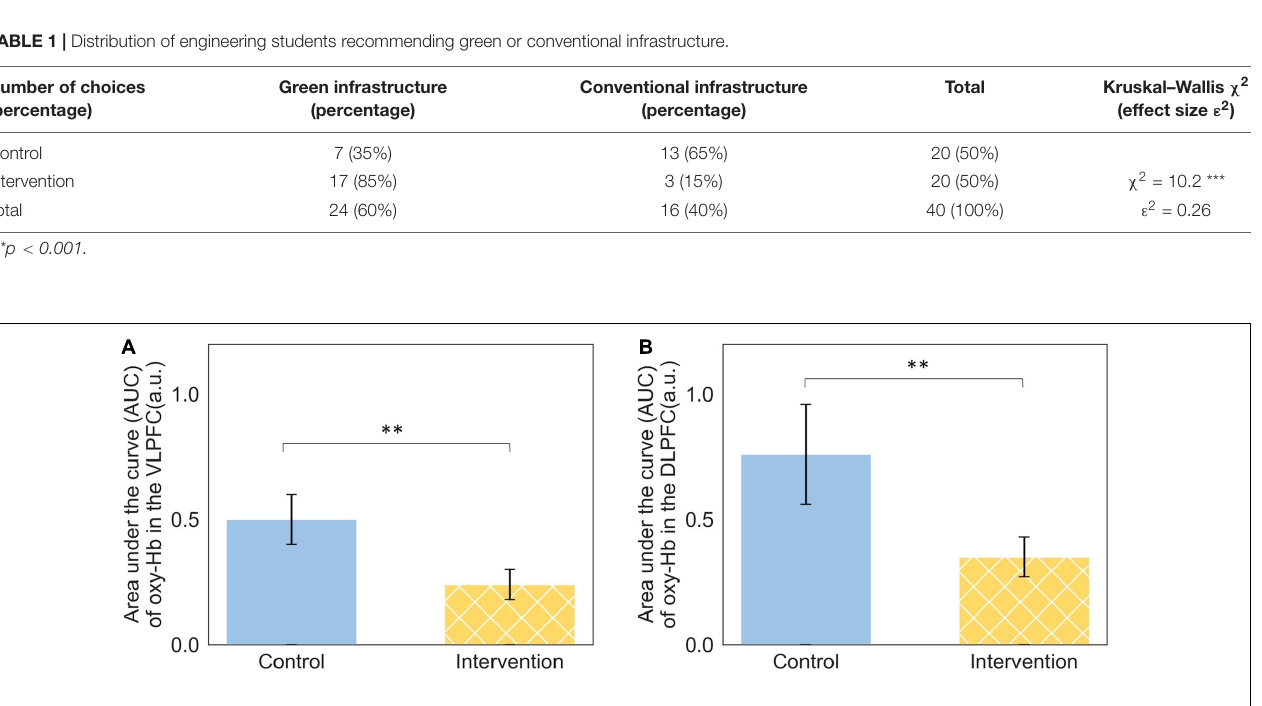
Total Kruskal–Wallis χ 2